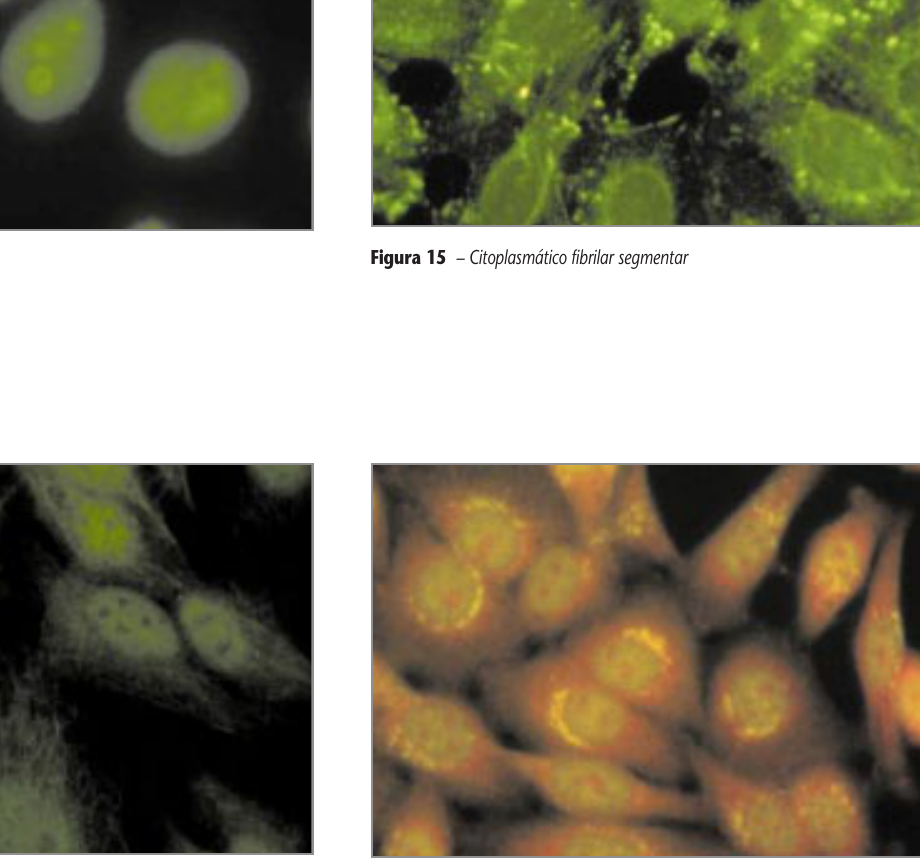
Figura 13 – Citoplasmático fibrilar linear